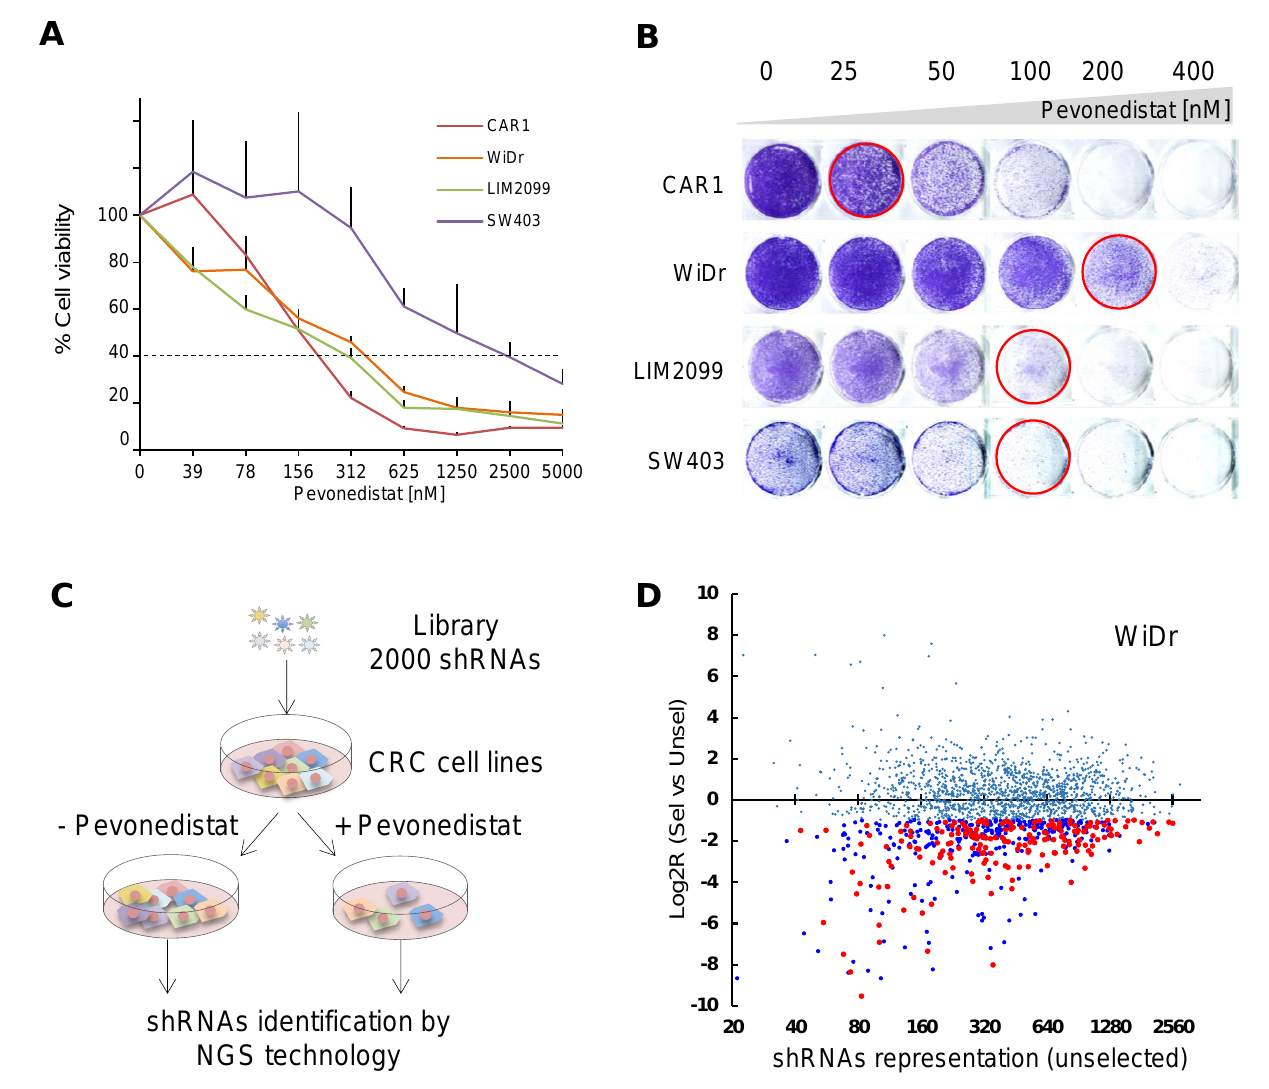
Figure 1. Genetic screening for synthetic lethality with pevonedistat in CRC cell lines. ( A ) Four CRC cell lines were treated with increasing concentrations of pevonedistat for 96 h, and short-term cell viability was determined by using Cell Titer Glo. Response of each cell line is reported as percentage of cell viability for n = 3 experiments (mean ± SD). ( B ) Long-term proliferation assay was performed for RAS/RAF WT CAR1, BRAF -mutant WiDr, and KRAS-mutant LIM2099 and SW403 cells in the presence of increasing concentrations of pevonedistat for 8 to 15 days. Plates were fixed with crystal violet. ( C ) Schematic representation of the in vitro drop-out shRNAs screening performed in the aforementioned CRC cell lines is reported. Each cell line was infected in three independent experiments with the library composed of 2000 shRNAs targeting druggable genes and then treated (+) or not ( − ) with pevonedistat for about 20 doublings in the absence and 10 doublings in the presence of the drug. Cell were harvested, and the library was amplified by PCR and sequenced by NGS technology. ( D ) Representative scatter plot of one screening in WiDr cells. The x-axis reports the abundance of each shRNA in unselected cells, expressed as counts per million; the y-axis reports the LOG 2 ratio (R) of shRNA representation in selected vs. unselected cells in the same screening. Light blue dots: not significant depleted shRNAs; dark blue dots: significant depleted shRNAs in one replica experiment; red dots: significant depleted shRNAs in triplicate experiments.